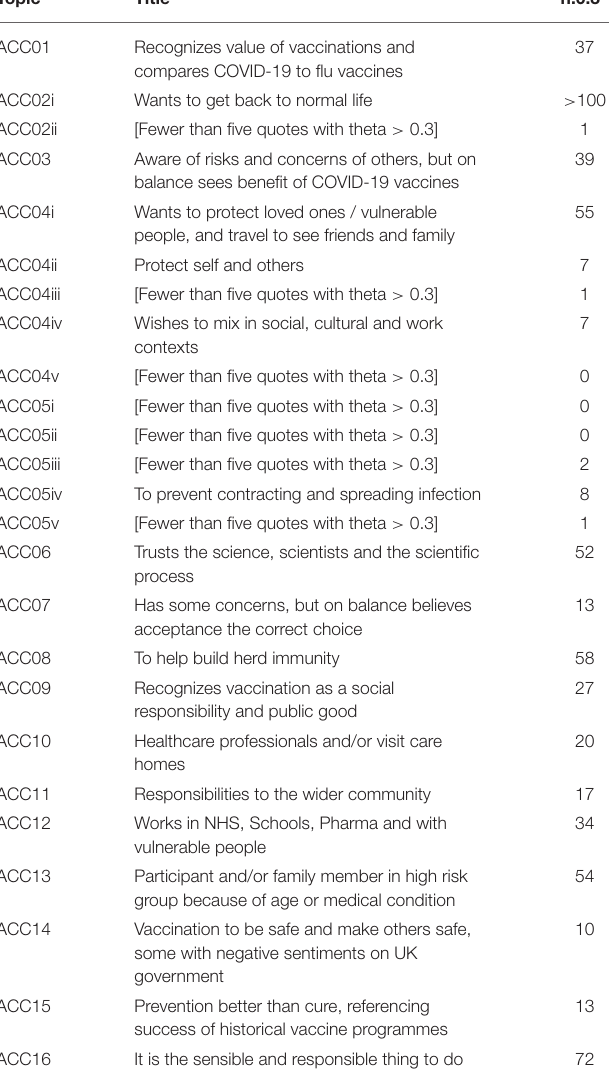
TABLE 3 | Topics summarizing reasons for intending to accept a COVID-19